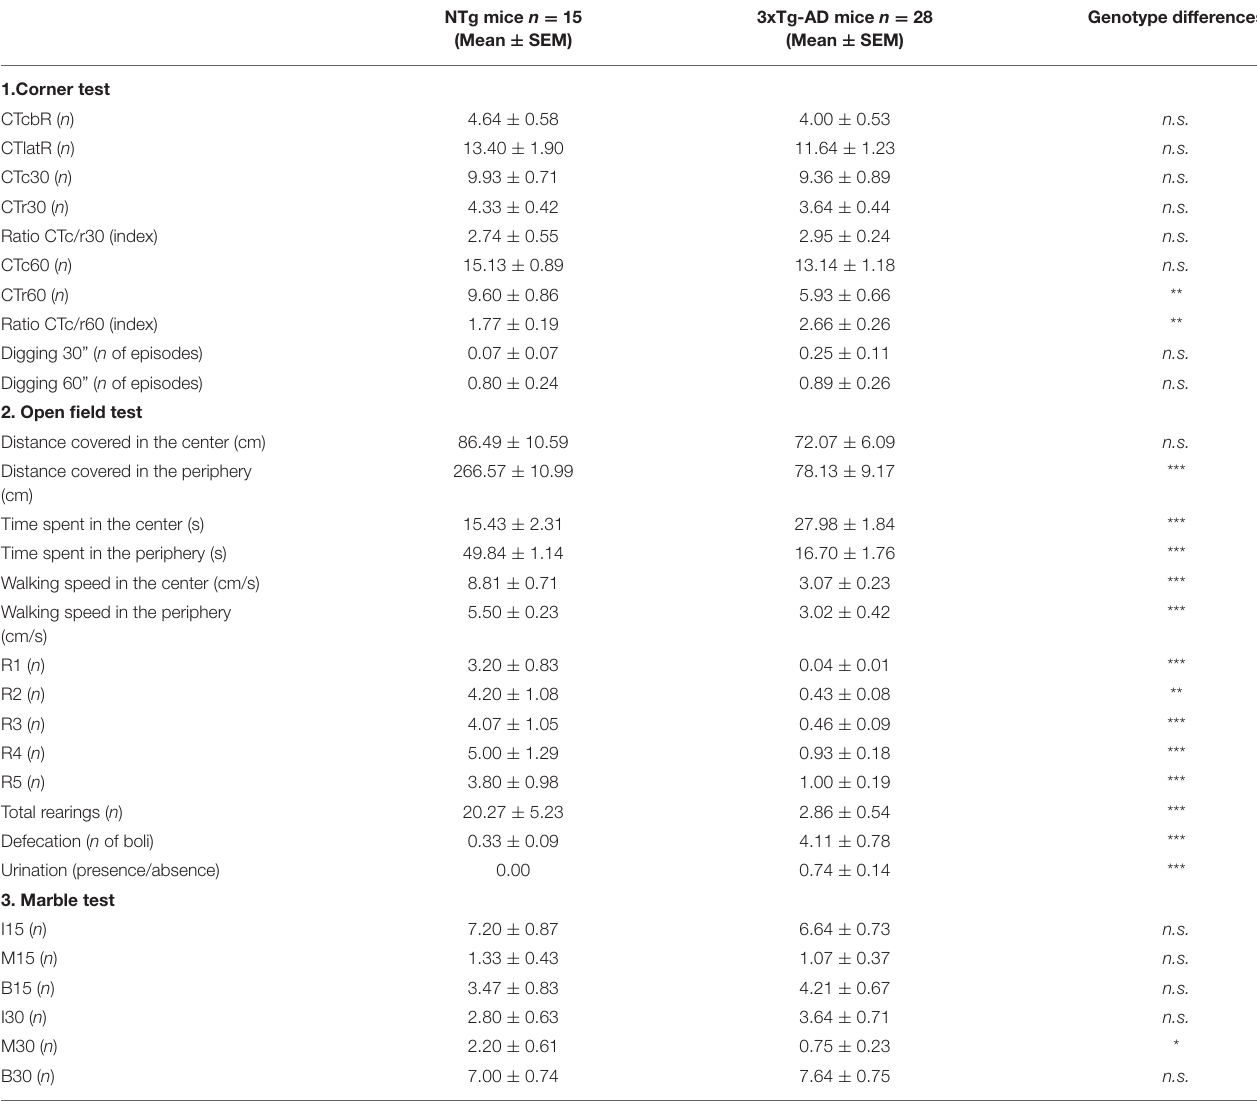
TABLE 1 | Genotype differences between 13-month-old male 3xTg-AD mice and NTg mice in the corner, open-field, and marble tests.